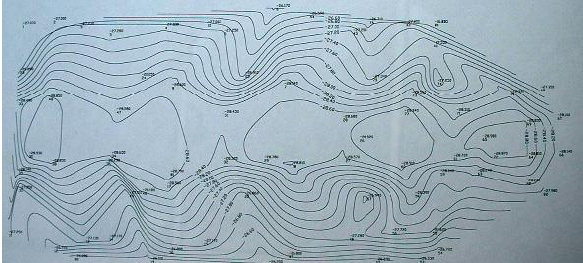
Figura 5. Plan with level curves of the nave vault of the church of Jerónimos monastery (Genin,